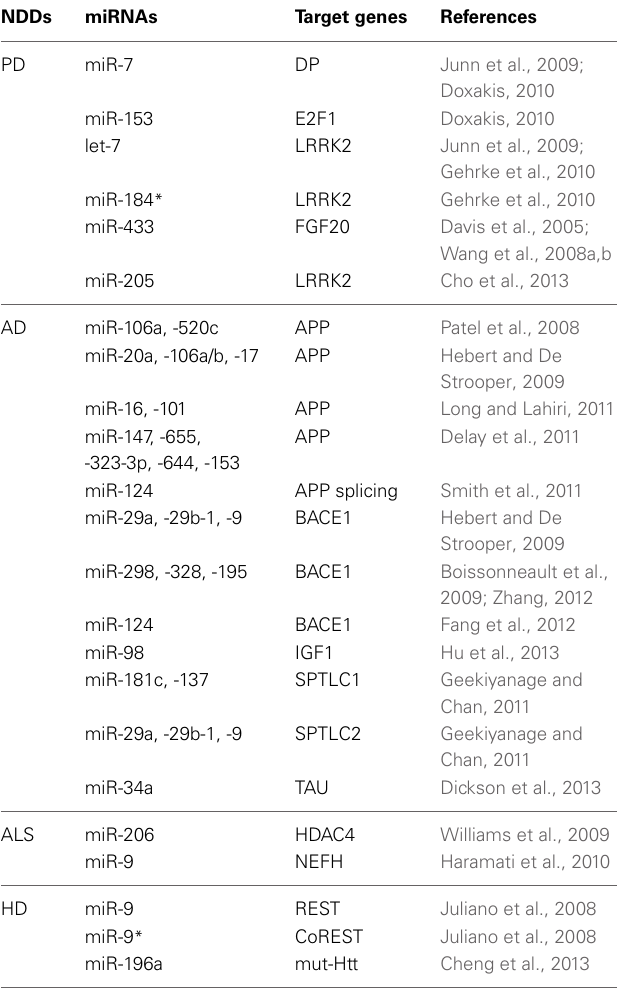
Table 1 | Specific target genes of miRNAs involved in neurodegeneration are